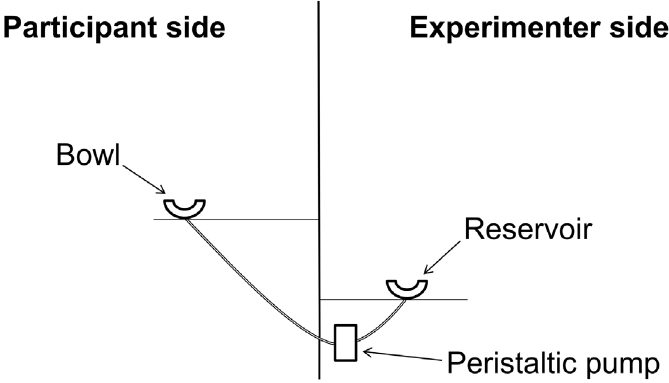
Fig 1. Depiction of the self-refilling soup bowl